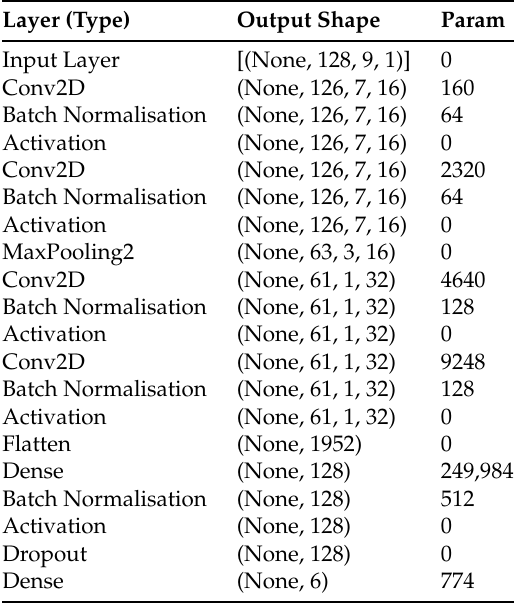
Table 8. Structure of designed CNN network model.